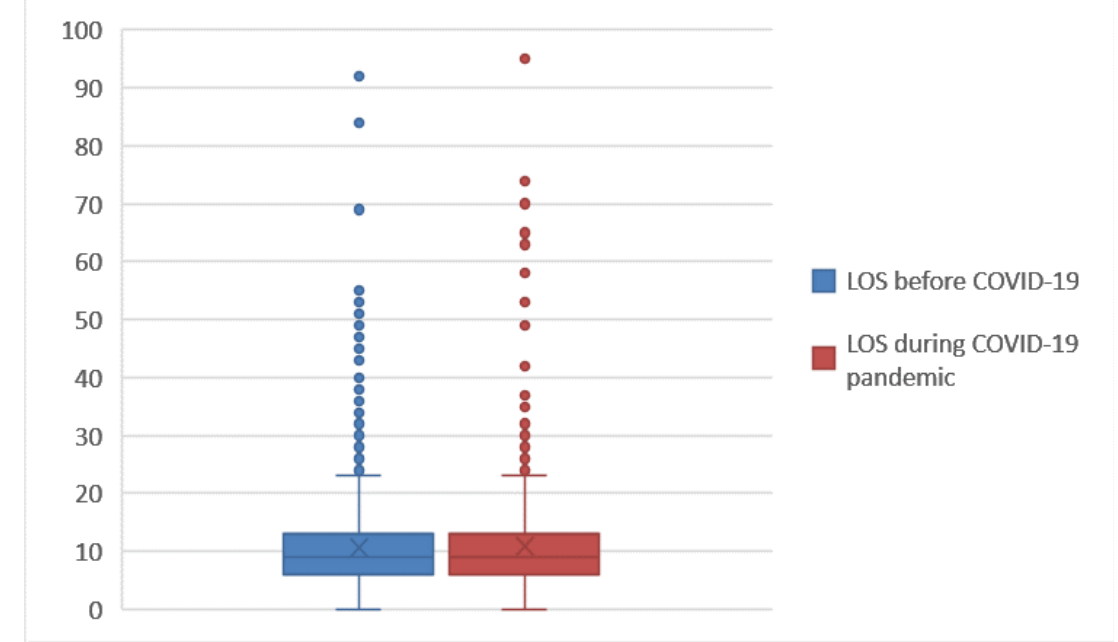
Figure 9. Box plot of LOS (2018 – 2019 vs. 2020 – 2021).